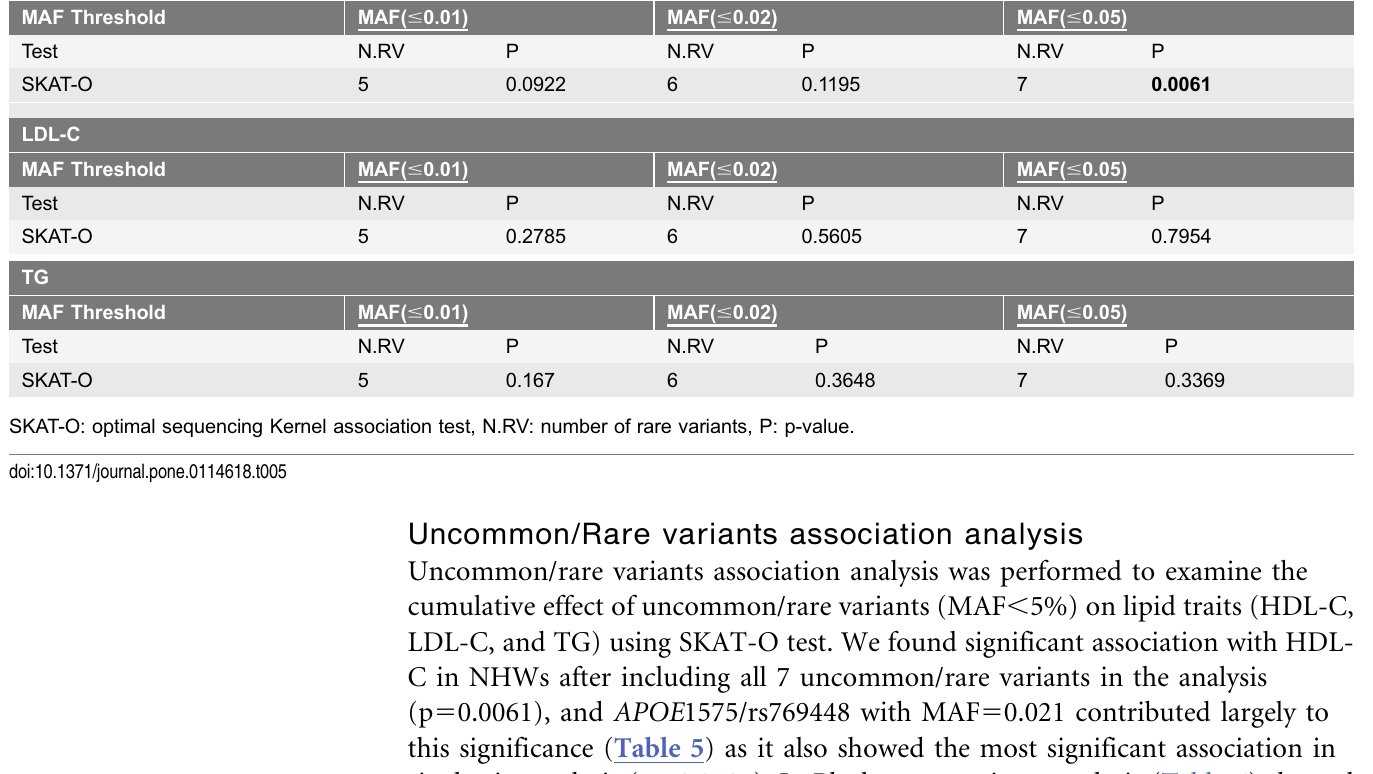
Table 5. Rare/uncommon (MAF , 5%) variants analysis with lipid traits in NHWs. HDL-C MAF Threshold